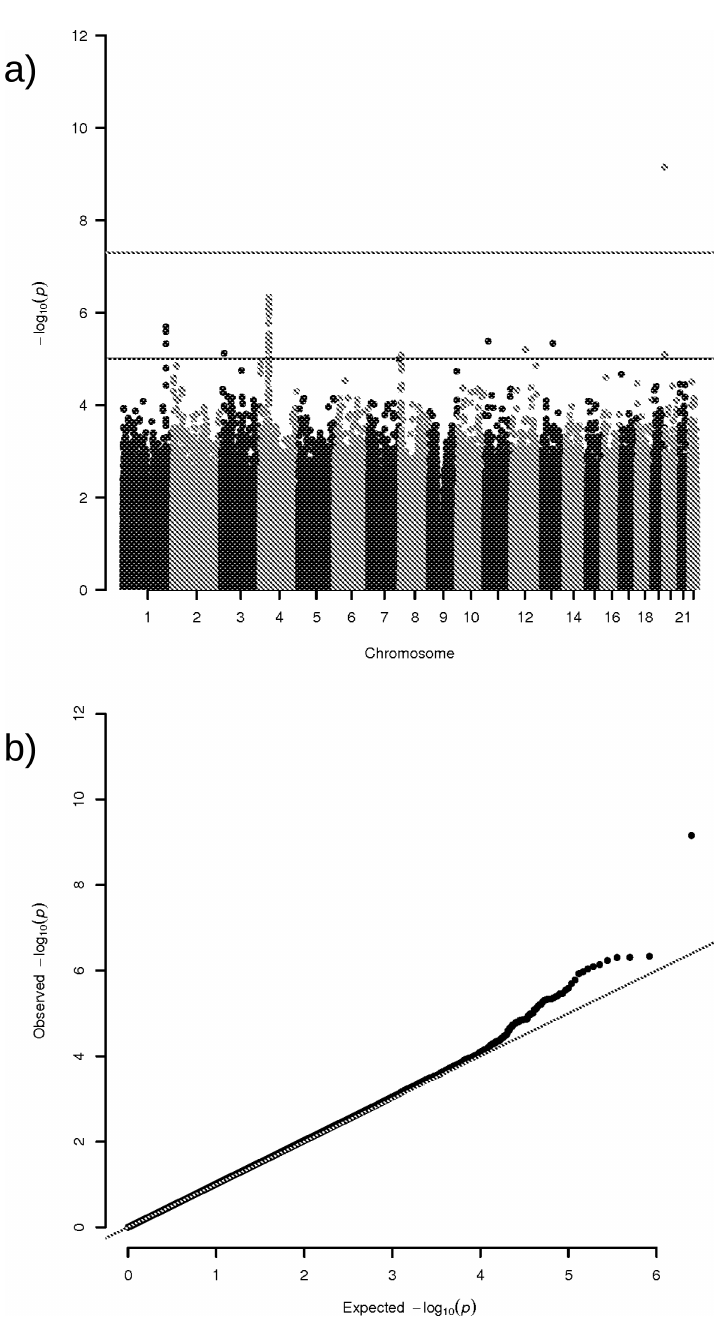
Fig 1. One locus on chromosome 20 reaches genome-wide significance in the GCTA-LOCO association analysis. (a) Manhattan plot of genome-wide association for self-reported helping behaviour. (b) Quantile-quantile plot of GWAS for self-reported helping